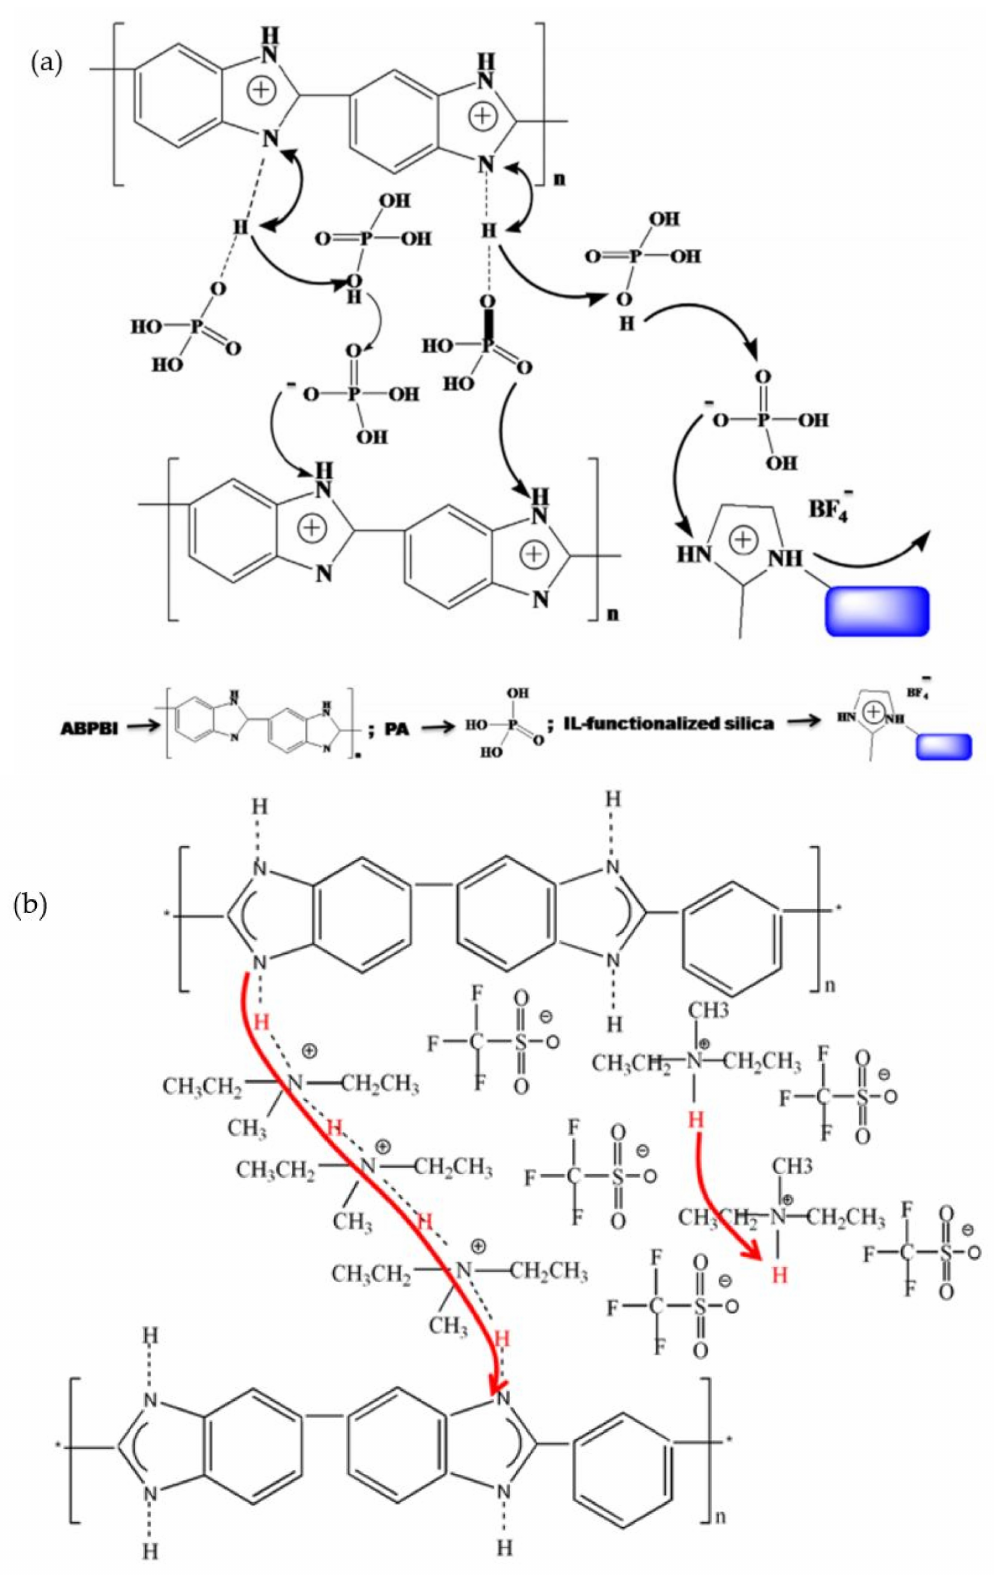
Figure 13. Mechanism of proton conduction in phosphoric acid-doped AB-PBI membrane with ionic liquid compound suggested by ( a ) Mishra et al. [122] and ( b ) Liu et al.